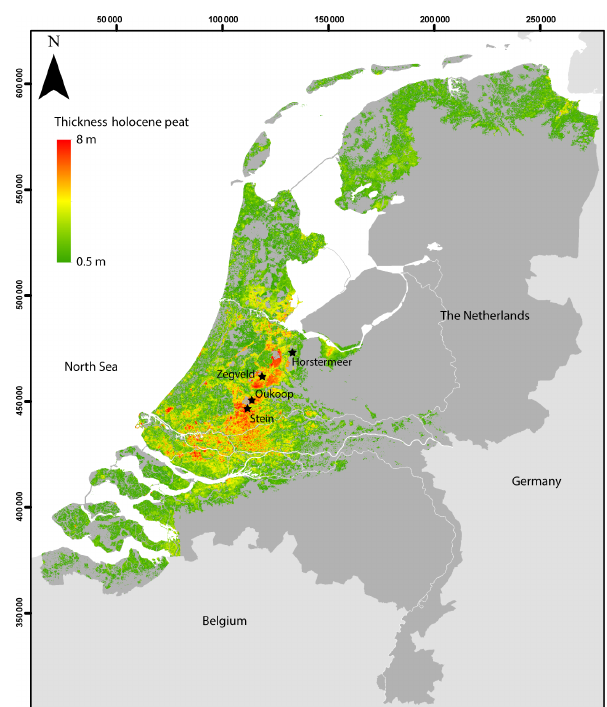
Figure 1. Map of the Netherlands showing accumulated thickness of Holocene peat from the GeoTOP model (TNO-GSN, 2019). The stars indicates the locations of the four monitoring sites. Coordi- nates are expressed in meters using the RD (Rijksdriehoek) local coordinate system. © TNO Geological Survey of the Netherlands